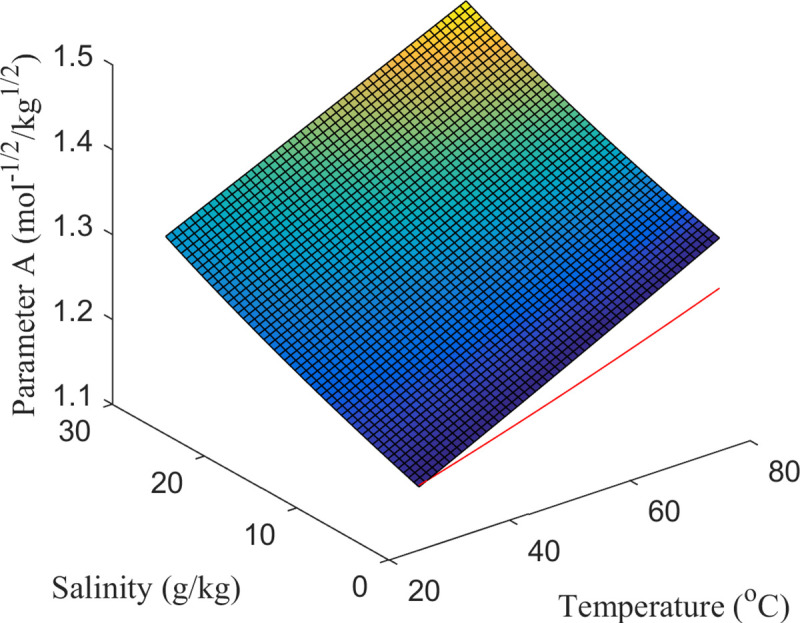
Calculation of the parameter A.The red line refers to the temperature-dependent function (Eq 5), whereas the surface is the temperature/salinity-dependent function (Eq 6).